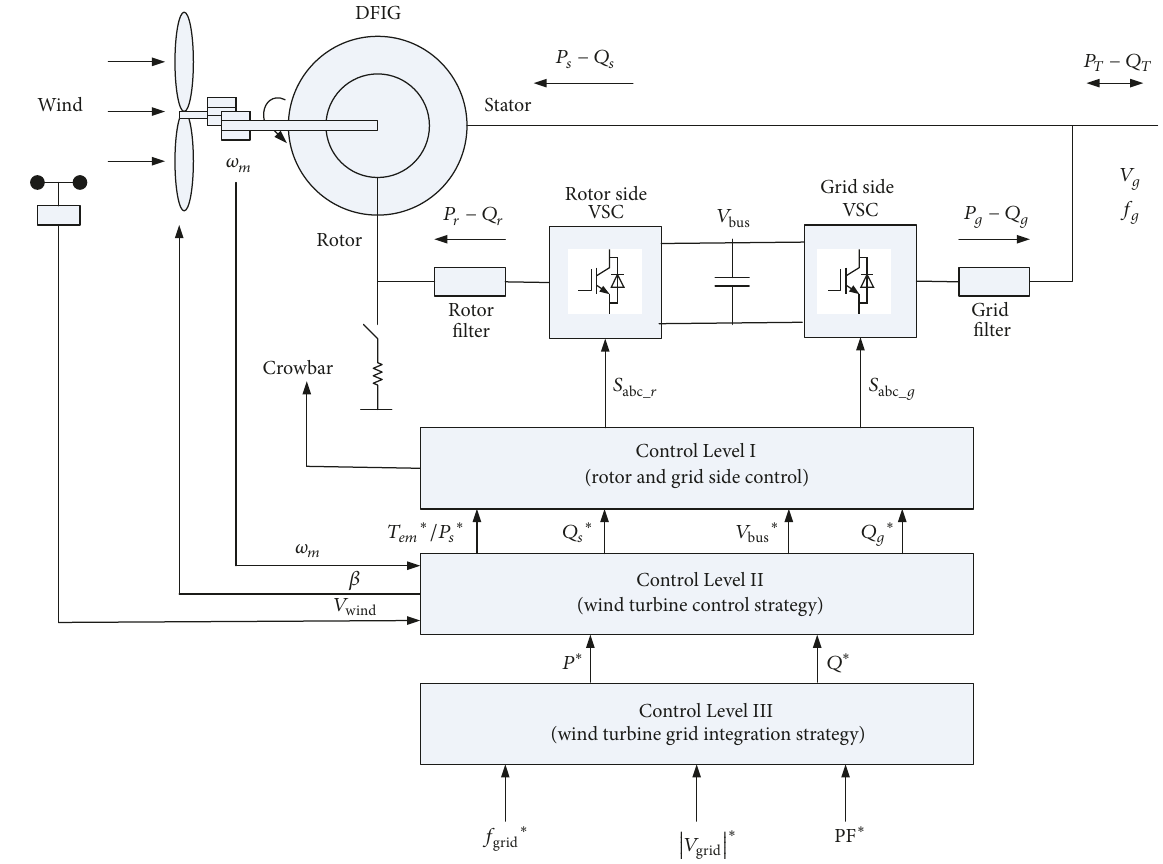
Figure 12: Conceptual diagram for DFIG wind turbine with partial scale power converter showing control strategy levels